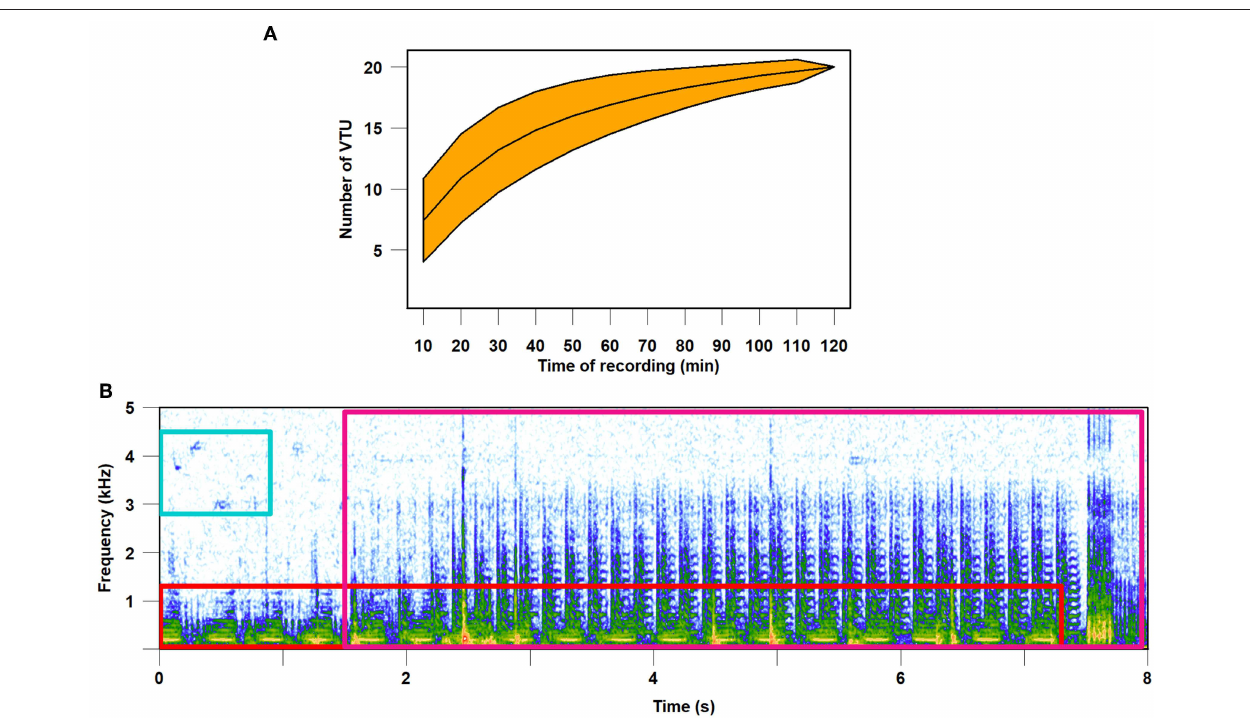
FIGURE 2 | Complexity of meadow vibroscape. Vibrational signals were registered with a laser vibrometer on Carex hirta during 2-h (14:30–16:30) recording session on July 9, 2018. (A) Species accumulation curve of vibrational taxonomic units (VTU). VTU is equivalent to species and each 10min of the recording was taken as a sample. Orange area around the curve indicates 95% confidence interval. The curve approaches 20 VTUs; however, it does not reach the plateau. (B) Visualization in the form of spectrogram of vibroscape, which includes overlapping vibrational signals of two unknown insect species (red and purple frames) and vibrational component of a bird air-borne song (blue